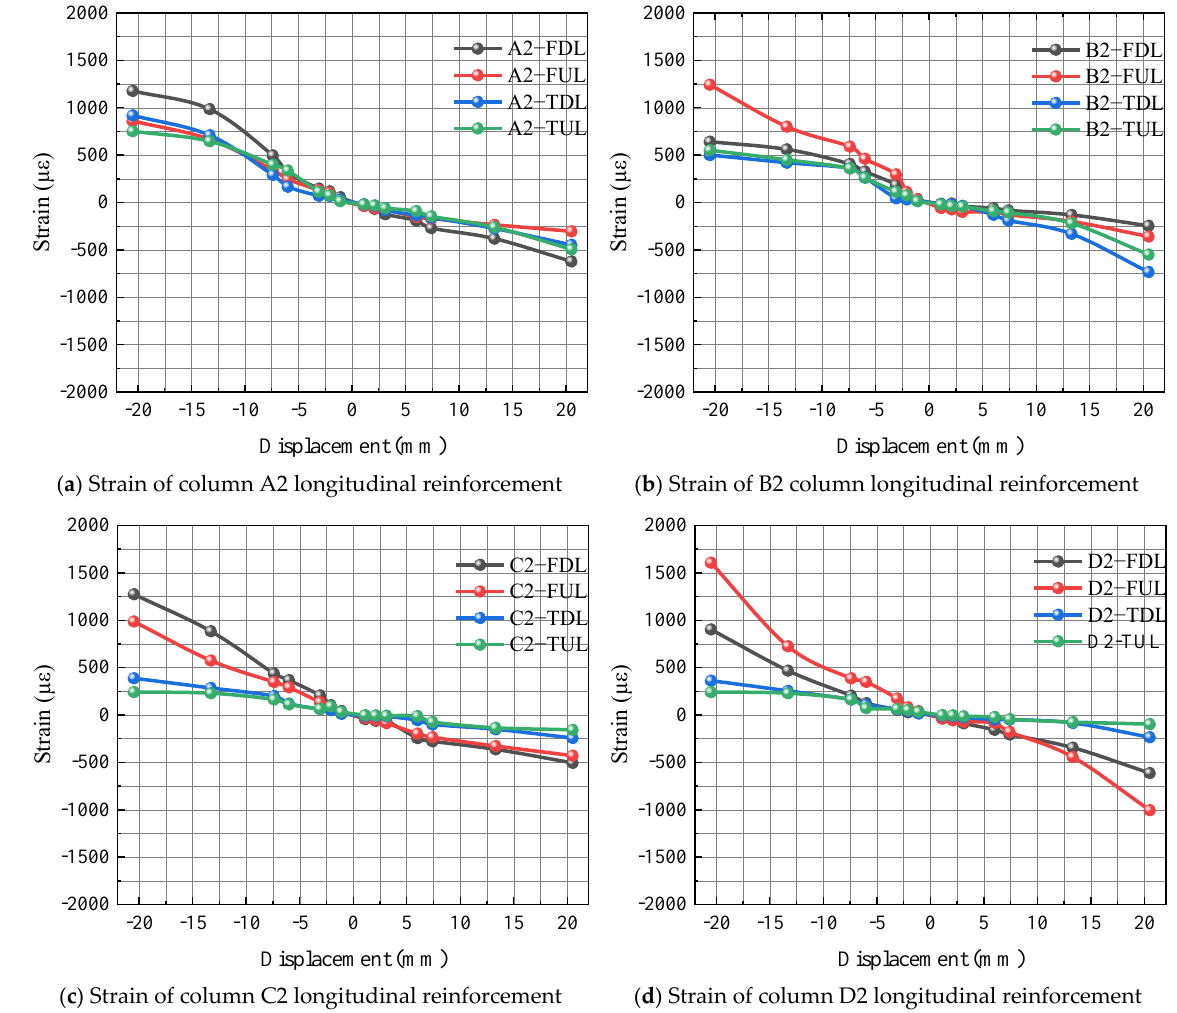
Figure 18. Longitudinal reinforcement strain of frame column.